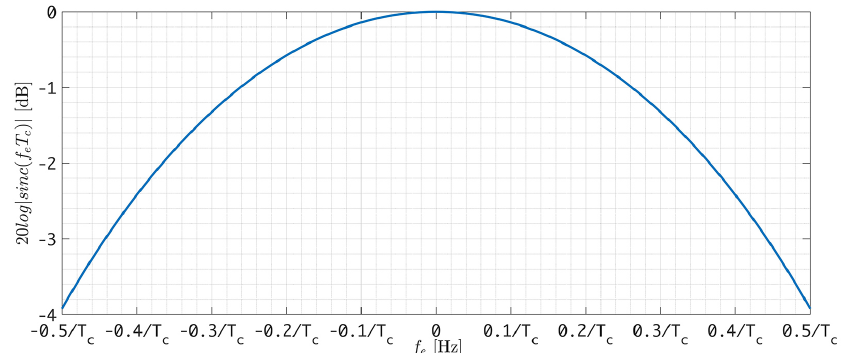
Figure 9. The relationship between coherent integral loss and frequency